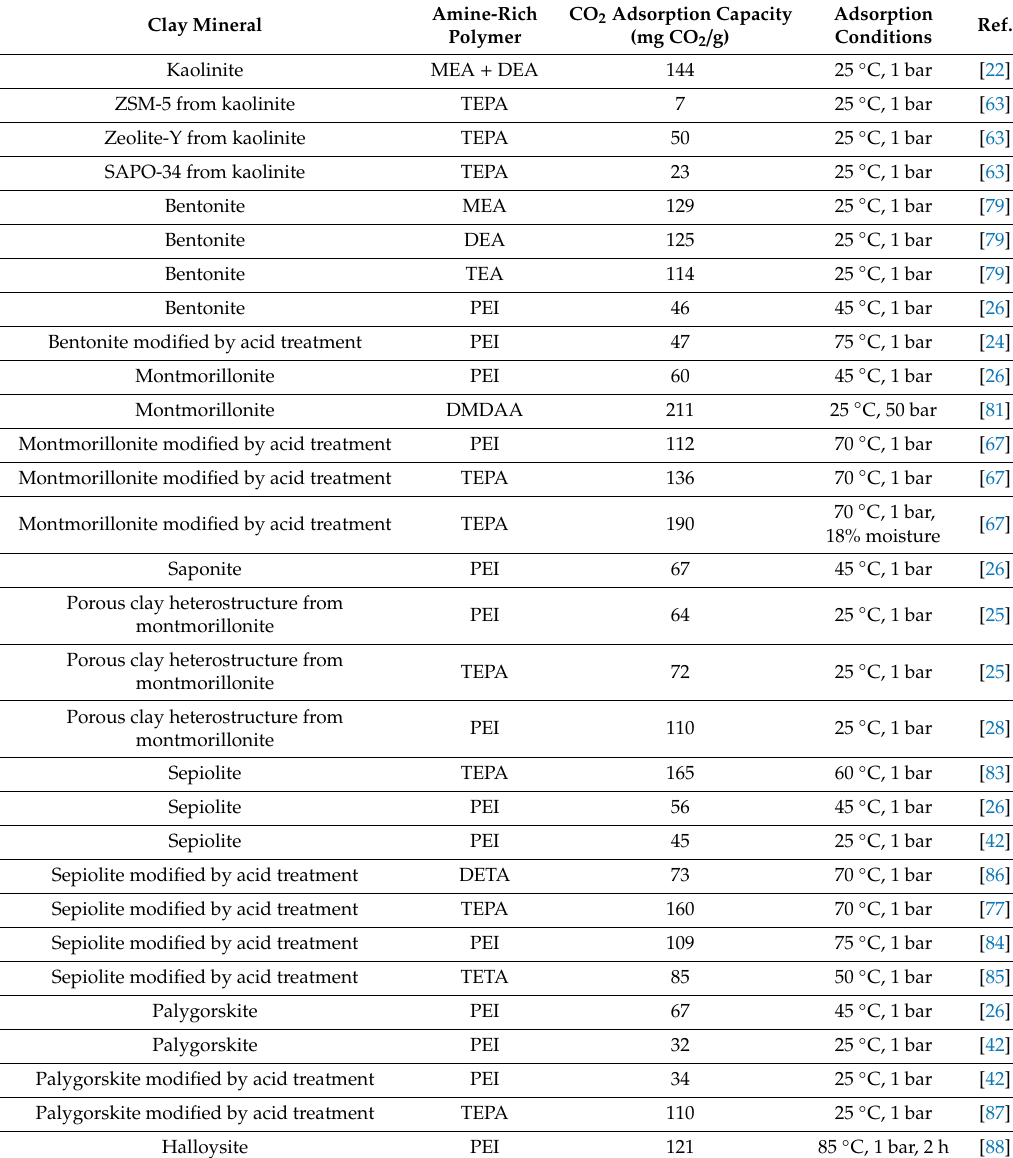
Table 6. CO 2 adsorption capacity of clay minerals functionalized with amine groups by impregnation. Clay